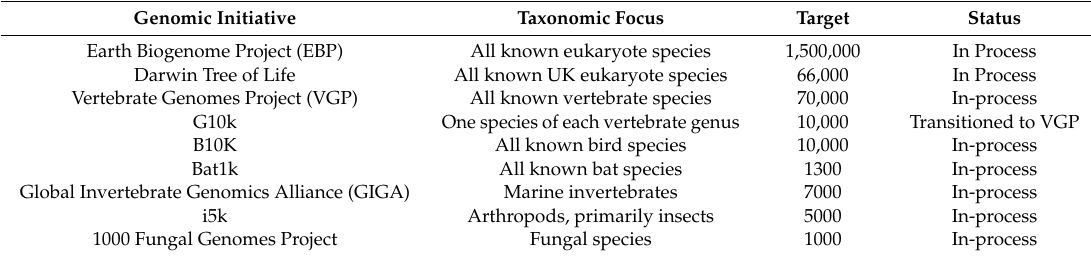
Table 1. List of some of the world’s genomics